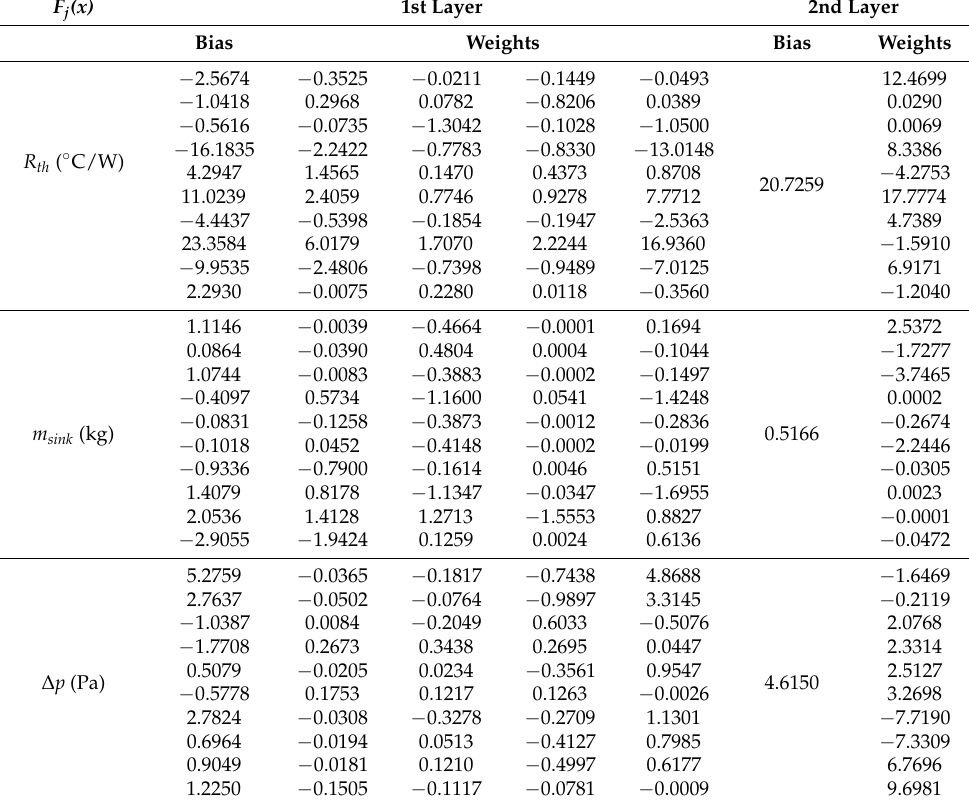
Table 3. Bias and weights for the neural networks here